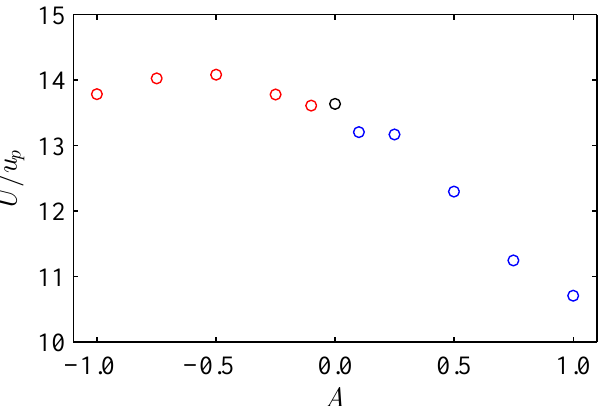
Figure 5. The relationship between the two velocity scales (the pressure-forcing velocity u and the high-altitude velocity U ) is shown for each forcing case. Cases that correlated p high-speed flow with upward and downward forcing are colored in red and blue,